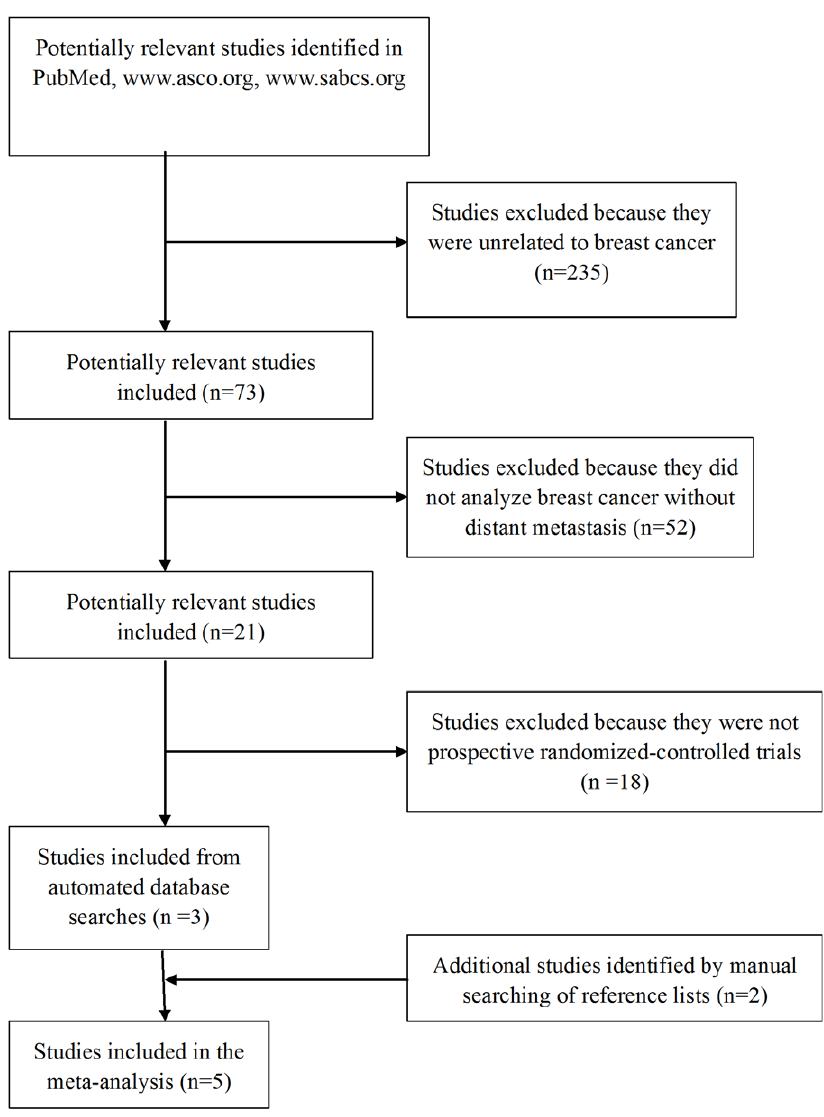
Figure 1. Flow chart of study selection.